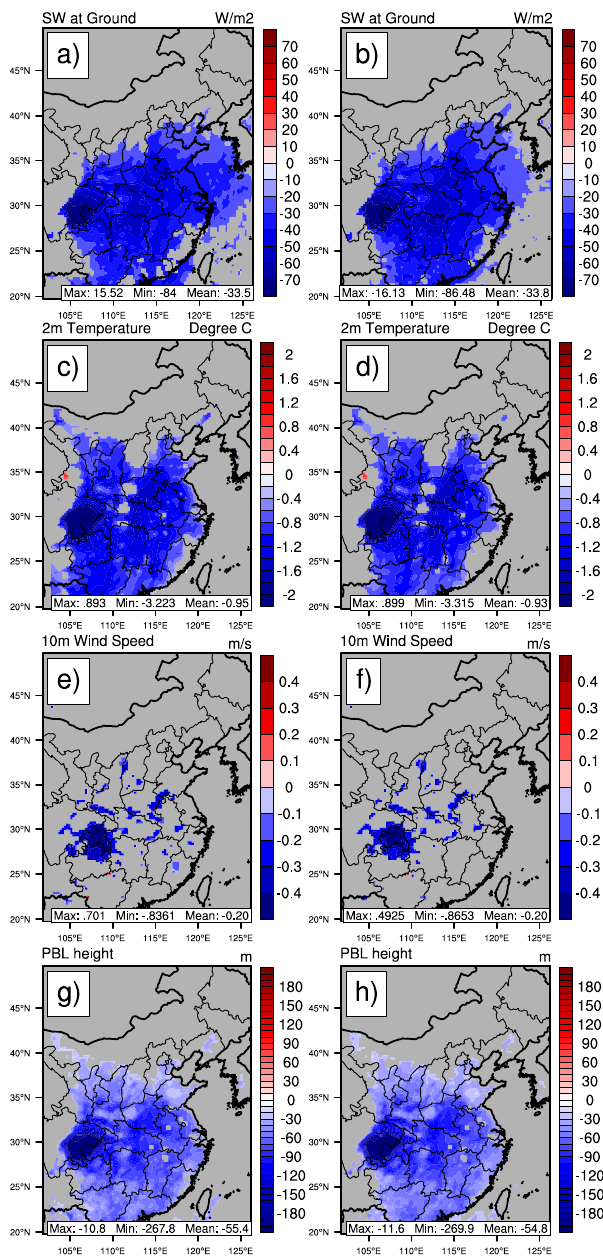
Figure 7. Simulated aerosol total effects (BASE − EMP) and radia- tive effects (RAD − EMP) on downward shortwave flux at ground, 2m temperature, 10m wind speed and PBL height in January 2013. The aerosol indirect effects on these four meteorological variables are not shown here since the induced changes are not significant ac- cording to Student’s t test. Grey shaded areas indicate regions with less than 95%